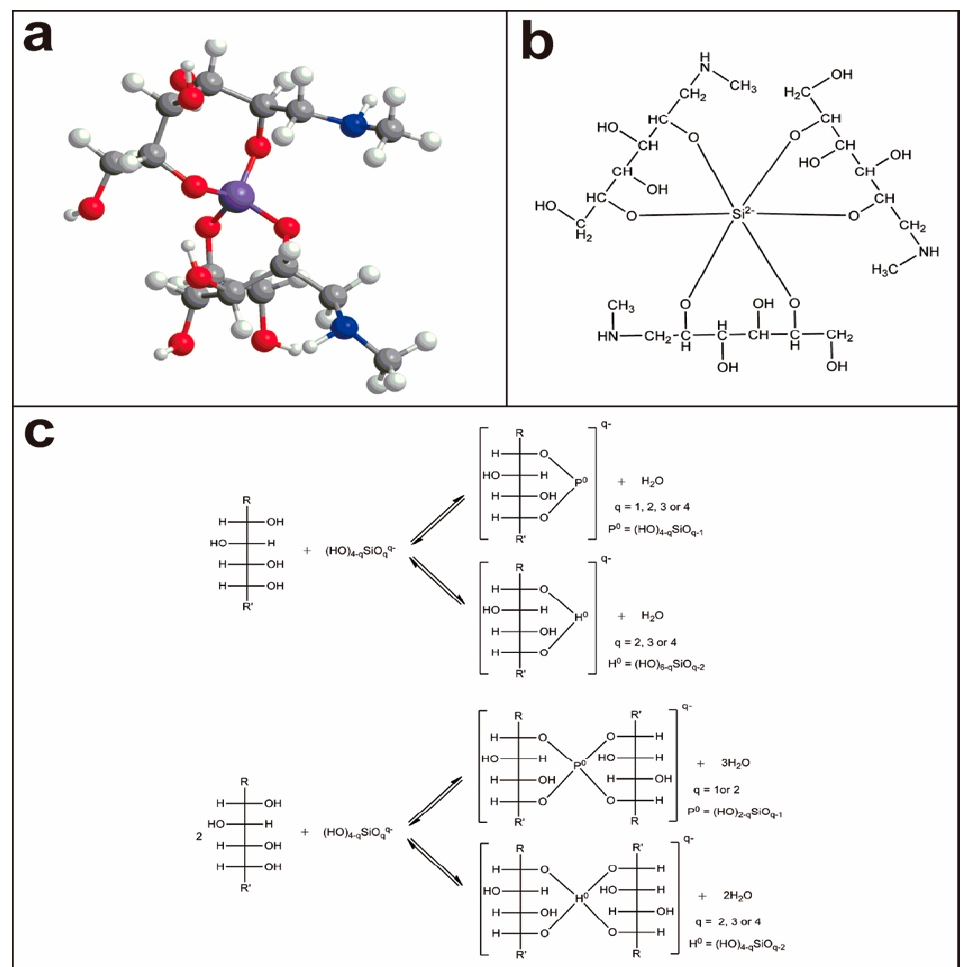
Figure 7. Molecular structures of organo-silicon complexes. Silicon is tetracoordinated ( a ) and hexacoordianted ( b ) with sugar; and in stable hypervalent ( c ) with straight-chain polyhydroxy compounds (data compiled from [78,127–132]).